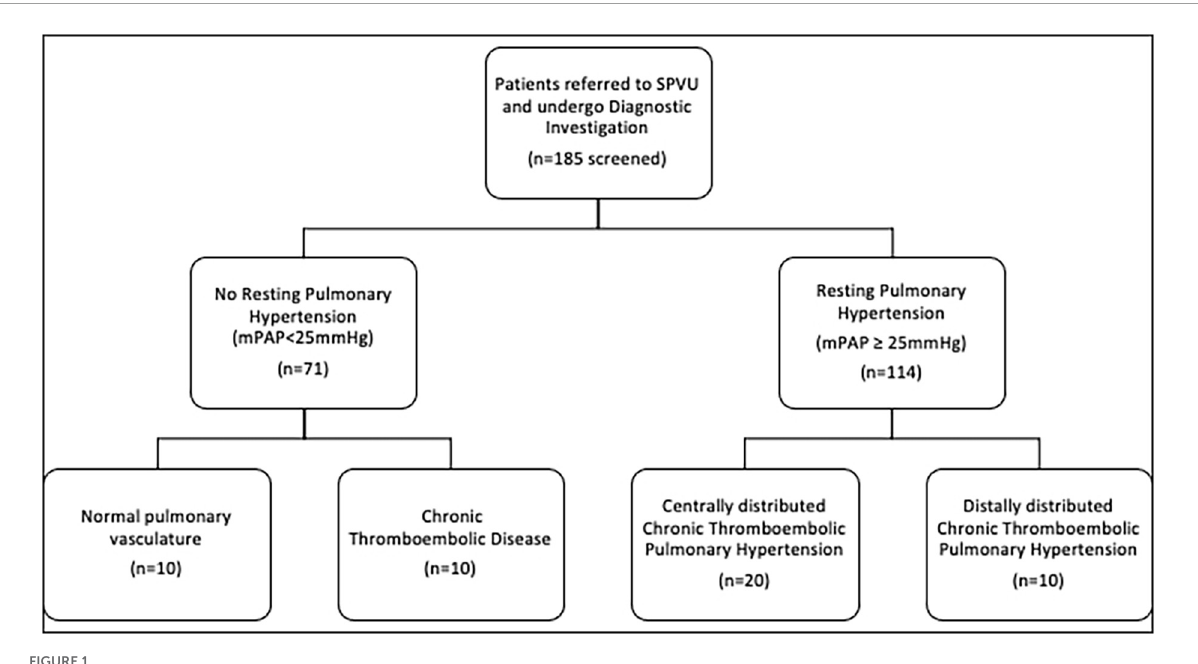
FIGURE1 Consort diagram of patient inclusion into the